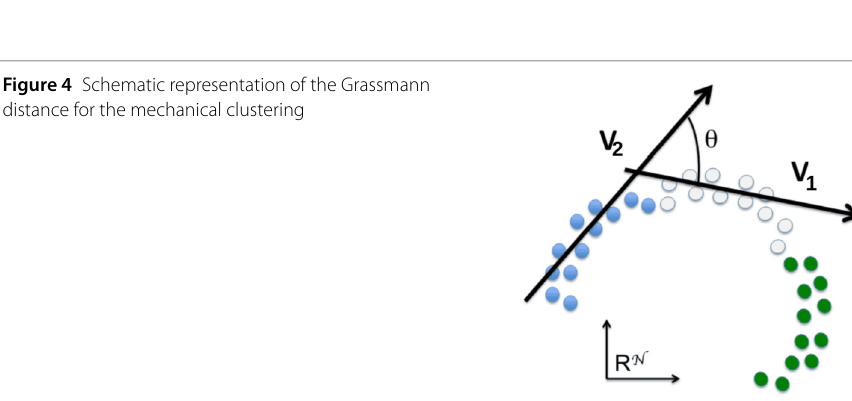
y and e z vertical and normal to the figure. Macroscopic strain loading: E yy = scale in percent)